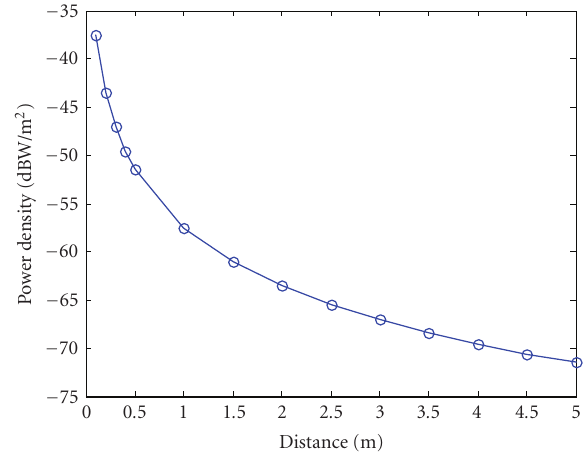
Figure 8: Relative electric field strength 20 log device to implant communication.